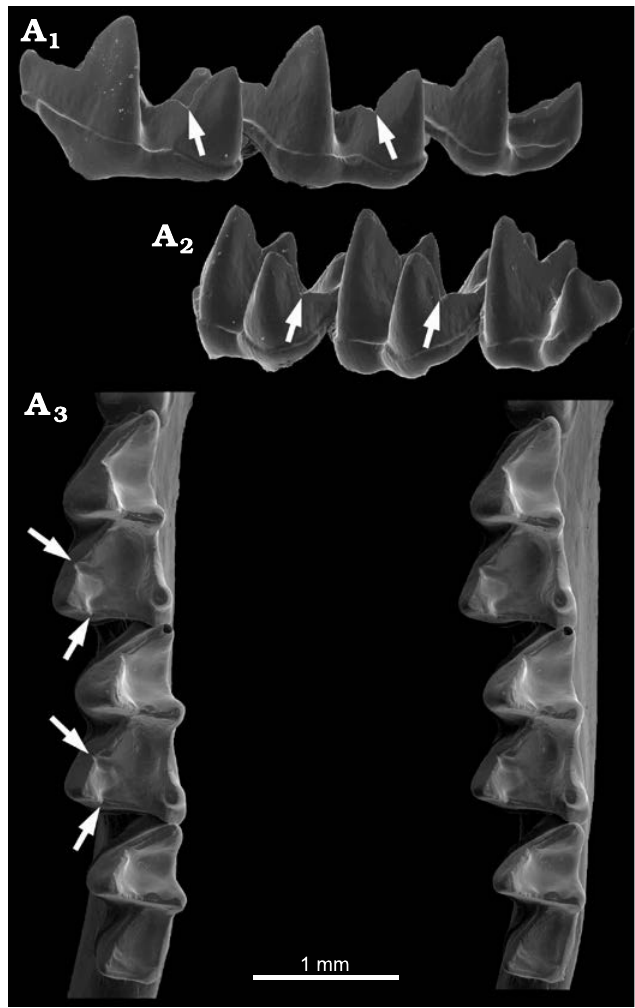
Fig. 7. Phyllostomid bat Lonchorhina orinocoensis Linares and Ojasti, 1971 (USNM 373254) from Venezuela, Recent. Left lower molars showing deep carnassiform notches in the talonids and accessory troughs in the talonid basins of m1–m2; A 1 , antero labial view showing cristid obliqua notches (ar- rows); A 2 , posterolabial view showing postcristid notches (arrows); A 3 (ste- reopair), occlusal view showing the talonid notches and troughs (arrows).